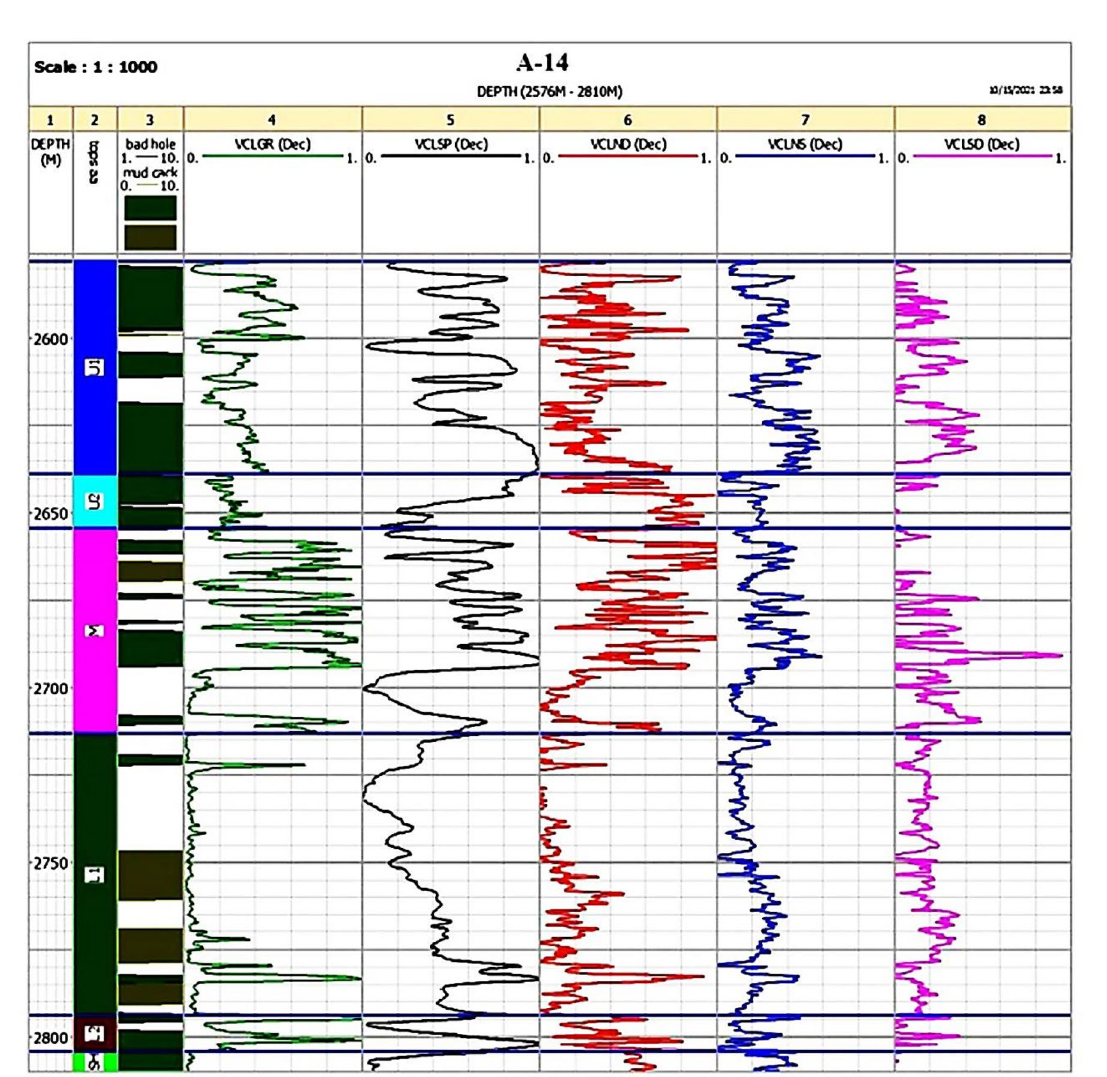
Fig. 5 Determining the shale volume of the Albian sequence in A-14 well using different